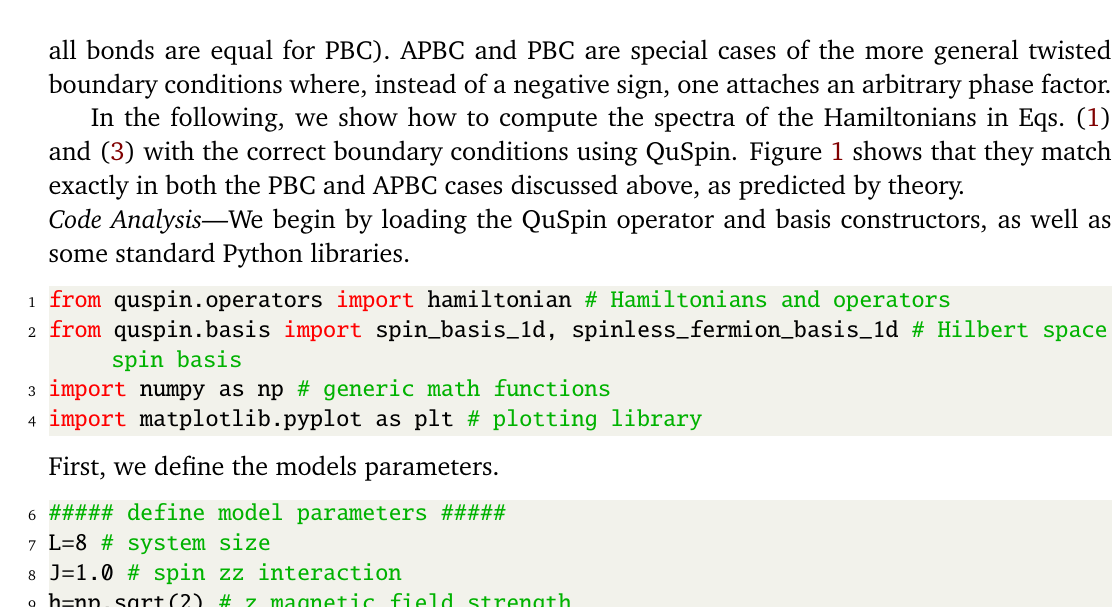
(cid:112) 2, and L =